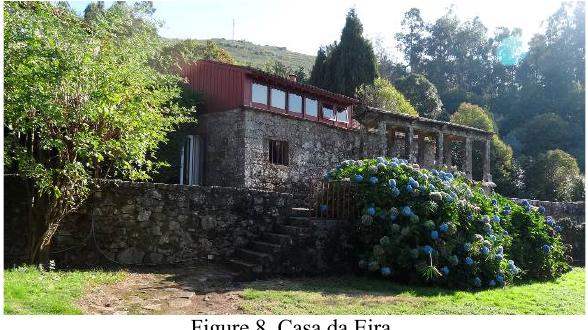
Figure 8. Casa da Eira.